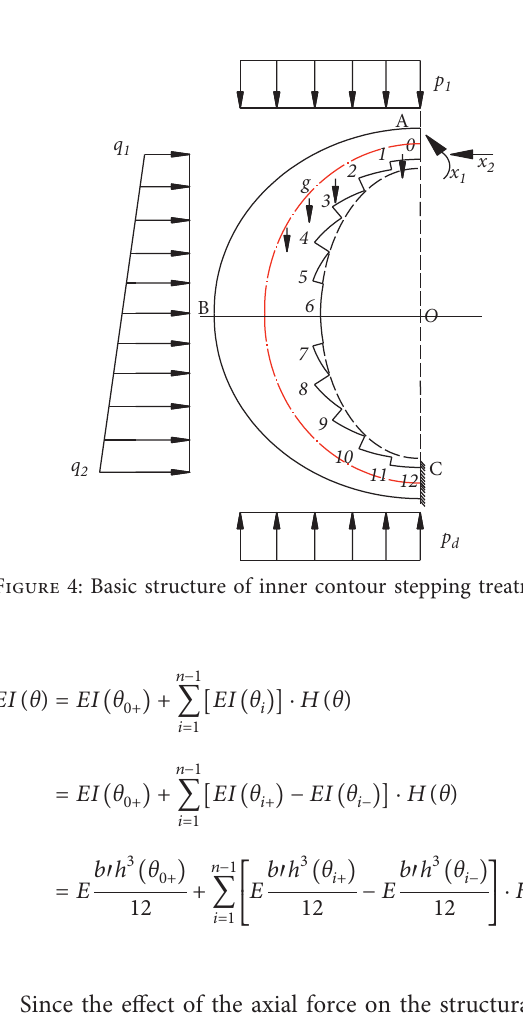
Figure 2: Load model and basic structure of outer circle and inner ellipse shield tunnel linings. (a) Load modeling. (b) Basic structure.